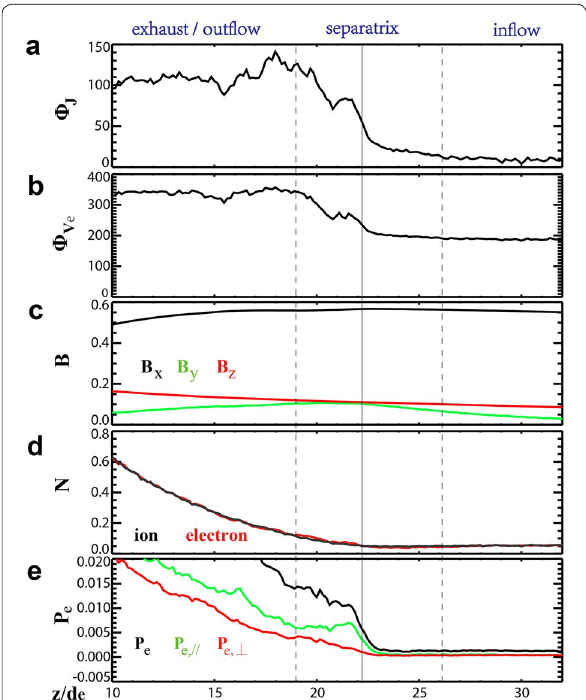
Fig. 4 Jump conditions when crossing the electron separatrix. a The azimuthal angle (in degree) of the current flow. The azimuthal angle is calculated in the xy-plane and ranged from 0° to 360°. 0° means the current flows along the x axis. The angle is counted in the clockwise + orientation. b The azimuthal angle of the electron bulk velocity. c The three components of the magnetic field. d The number densities of the ion ( black ) and electron ( red ). e The total electron pressure ( black ), the parallel electron pressure ( green ), and the perpendicular electron pressure ( red ). The vertical solid line marks the D ng peak, while the two vertical dashed lines mark the separatrix region where E z is